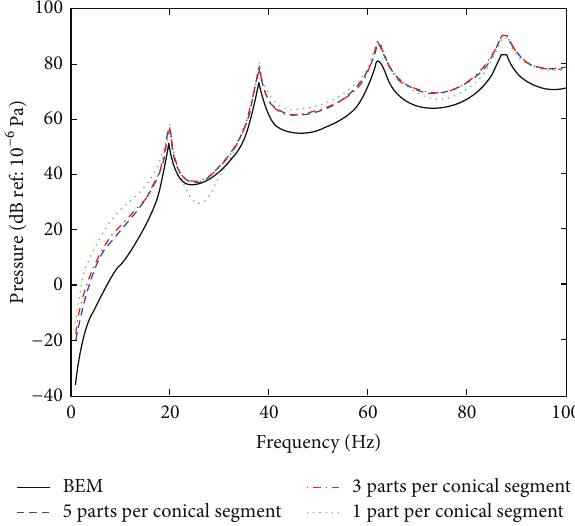
Figure 7: Comparison for different divisions for the conical shell.